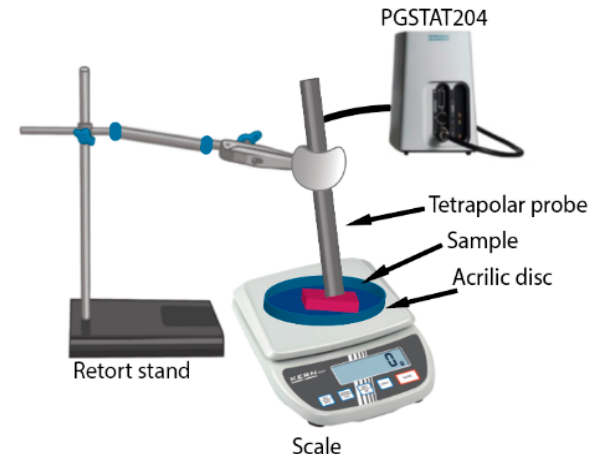
Figure 1. Measurement setup used to monitor the conductivity with the probe, the PGSTAT204 Galvanostat and retort stand used to lift and keep the probe fixed and the weighing scale.